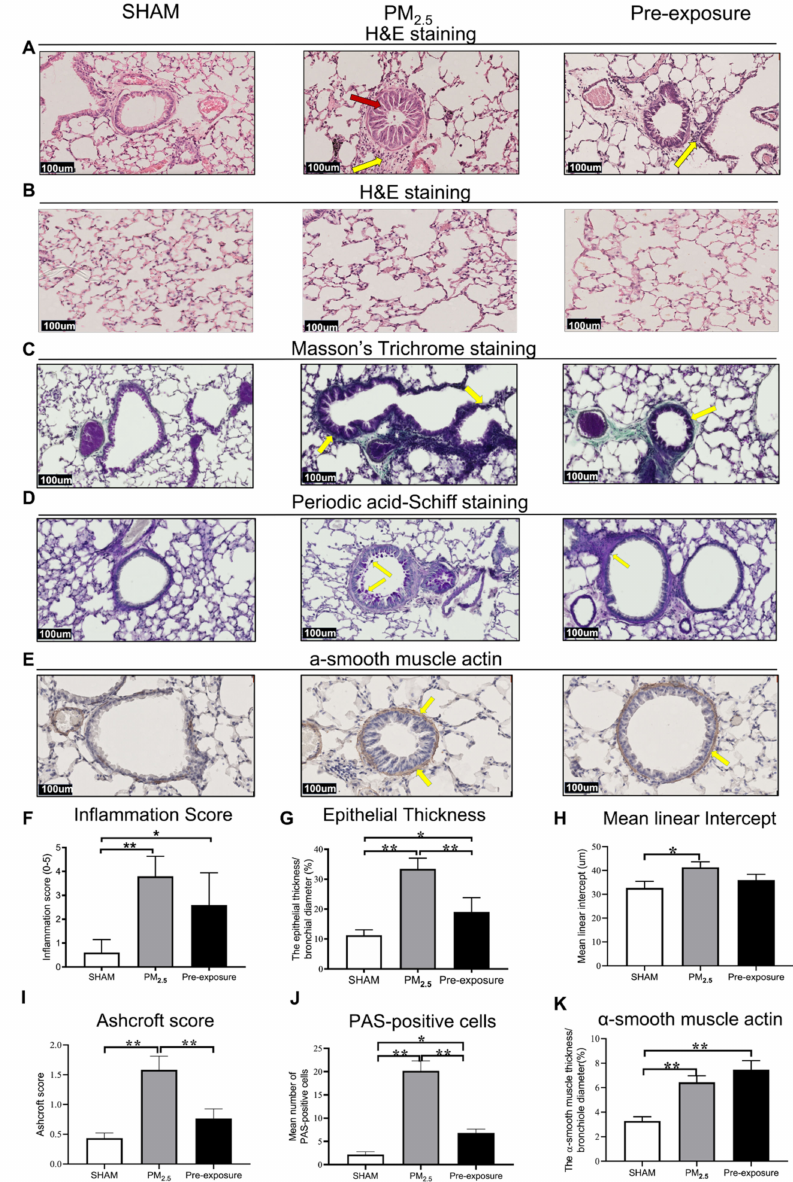
Figure 3. PM 2.5 exposure induced lung tissue remodelling in the dams. Representative images of lung sections stained with H&E staining of ( A ) the airway (yellow arrows point at immune cells and red arrow point at the enlarged epithelium in the bronchiole) and ( B ) parenchyma; ( C ) Masson’s trichrome staining (yellow arrows point at collagen); ( D ) Periodic acid-Schiff staining, with yellow arrows pointing at goblet cells; and ( E ) α -smooth muscle actin (yellow arrows point at α -smooth muscle actin positive cells). Quantitative results of ( F ) inflammation score, ( G ) epithelial thickness, ( H ) mean linear intercept, ( I ) Ashcroft score, ( J ) PAS-positive cells and ( K ) α -smooth muscle actin. Data were analysed by one-way ANOVA followed by Fisher’s LSD post hoc tests. n = 8. * p < 0.05, ** p < 0.01. PM 2.5 : dams exposed to PM 2.5 (5 µ g/day) prior to mating for 6 weeks during gestation and lactation. Pre-exposure: dams exposed to PM 2.5 for 6 weeks prior to